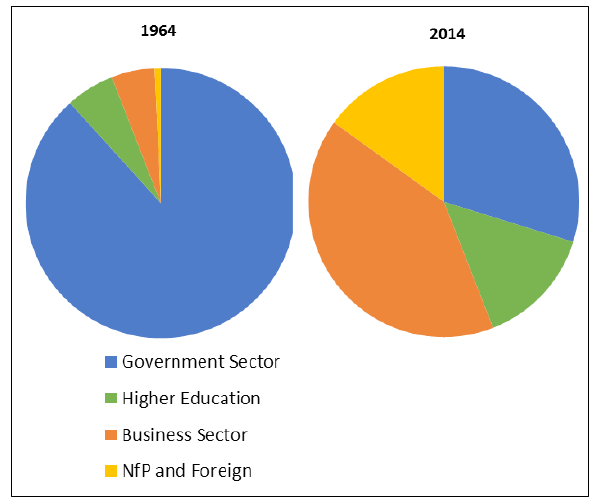
Profile of R&D expenditure in South Africa by source of funds, 1964 and